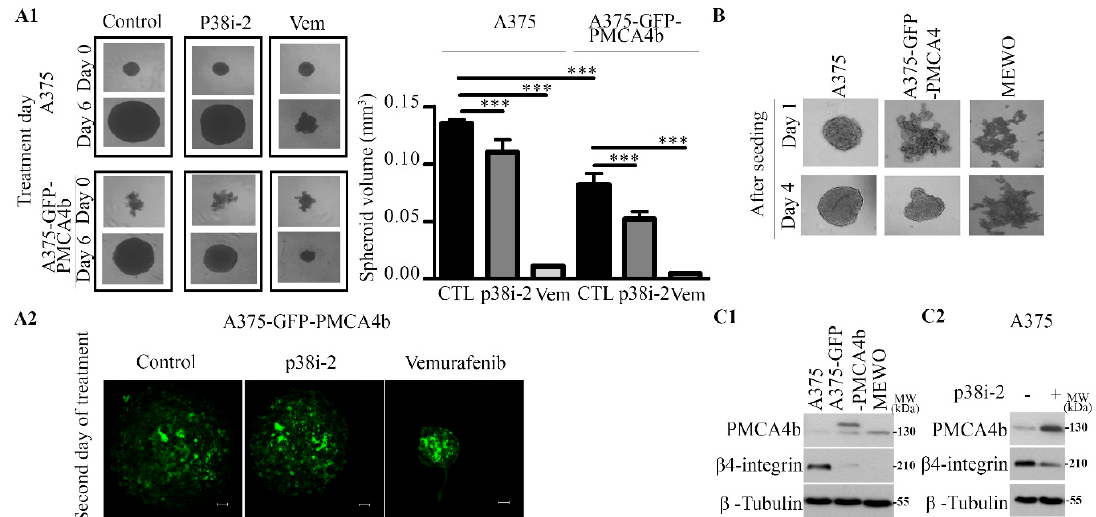
Figure 7. P38 inhibitor slightly reduced A375 cell spheroid growth, while A375-GFP-PMCA4b cells showed a delay in spheroid formation and MEWO cells did not form spheroids. ( A1 ) A375 and A375-GFP-PMCA4b cells were seeded in POLY-HEMA treated 96 well round bottom plate and incubated for 3 days for spheroid formation. At the third day (zero-time point.), cells were treated with 0.5 µ M vemurafenib or 10 µ M SB202190 for 6 days. Images were taken at 0 and 6-day time points using light microscope, 4 × . The spheroid area and radius were determined and spheroid volume (mm 3 ) was calculated. Data are means ± SD of three independent experiments. ( A2 ) For fluorescence microscopy, A375-GFP-PMCA4b cell spheroids were formed for 3 days, then 0.5 µ M vemurafenib or 10 µ M SB202190 were added to the media and incubated for an additional 48 h. Spheroids were fixed and Z-stack images were taken using Axio Imager.M2 microscope (ZEISS) with an ApoTome2 grid confocal unit (ZEISS), 20x objective. Scale bar, 100 µ m. ( B ) A375, A375-GFP-PMCA4b and MEWO cells were seeded on POLY-HEMA treated round bottom 96-well plate and incubated for 4 days for spheroid formation. Images were taken at 1 and 4-day time points using light microscope, 4 × . ( C1 ) A375, A375-GFP-PMCA4b cells and MEWO cells were seeded in a 6-well plate and grown for 48 h. ( C2 ) A375 cells were seeded in 6-well plate and treated with 10 µ M SB202190 for 48 h. ( C1 , C2 ) Protein expression level was analyzed by Western blotting with anti- β -integrin antibody. Western blot results are representative of three independent experiments.